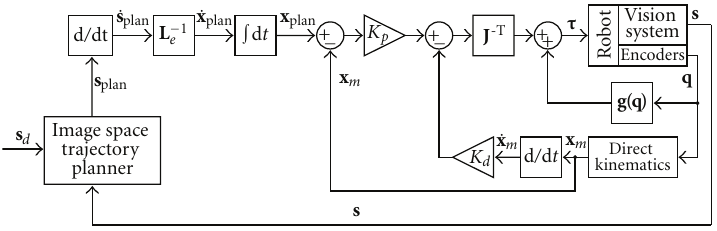
Figure 7: Dynamic look and move IBVS control.